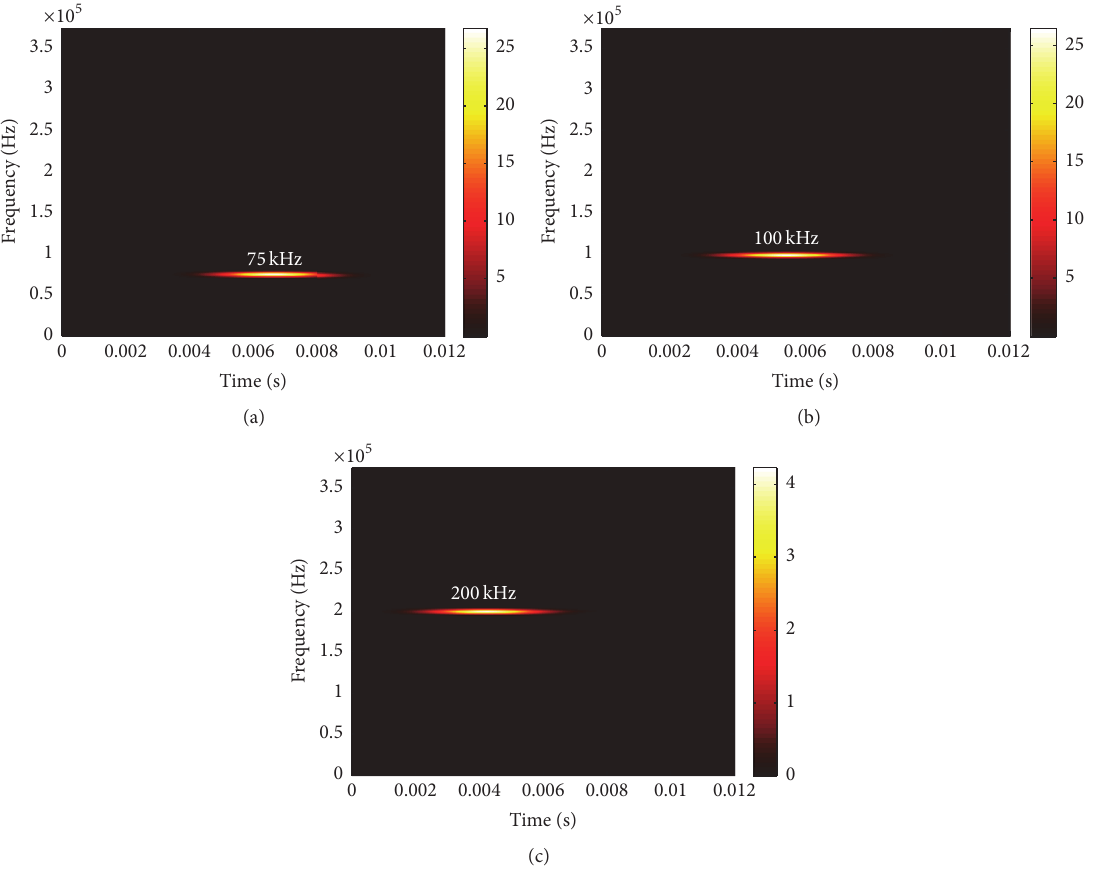
Figure 9: The filtering result of the SPWVD of the sample